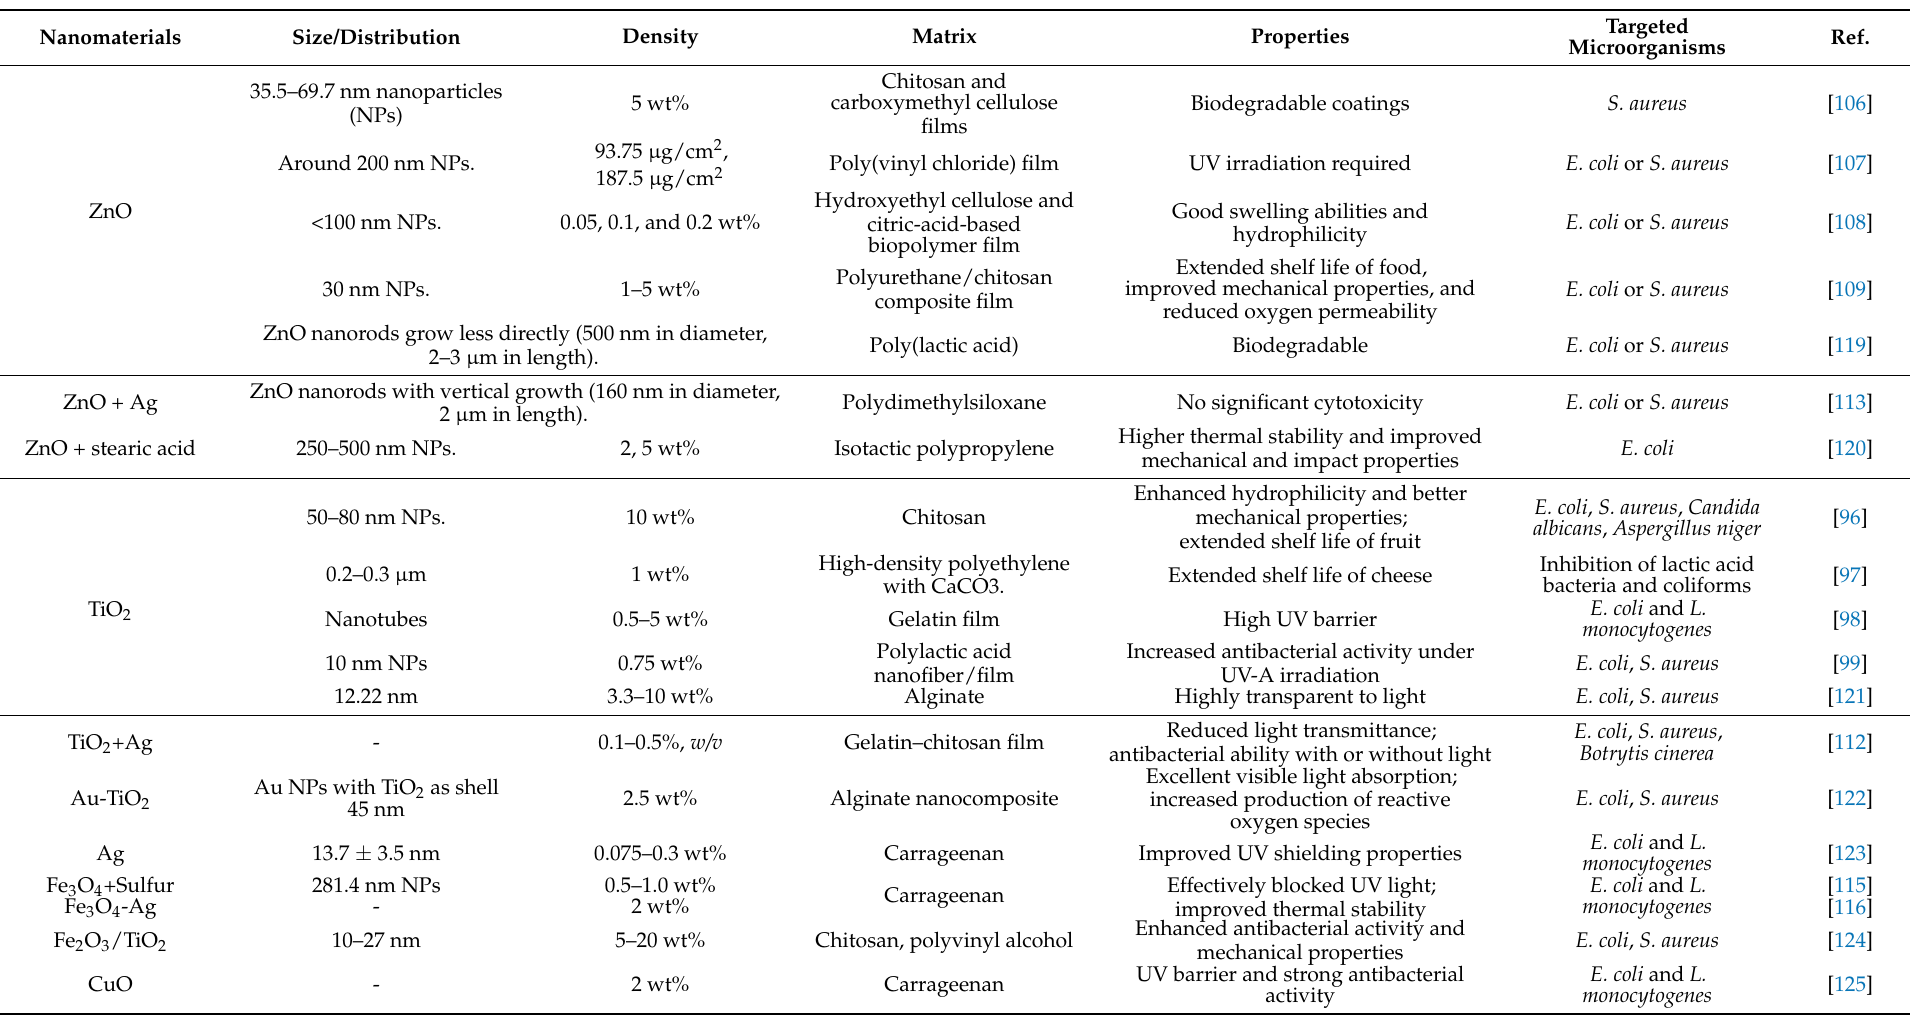
Table 2. Metal and metal oxide nanostructures integrated with biopolymers for active food